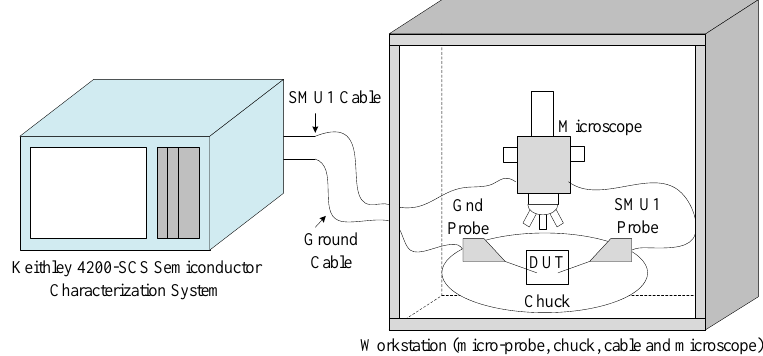
Figure 7. Current-Voltage behavior for memristor mechanism ( a ) TiO 2 layer and ( b ) equivalent circuitry.